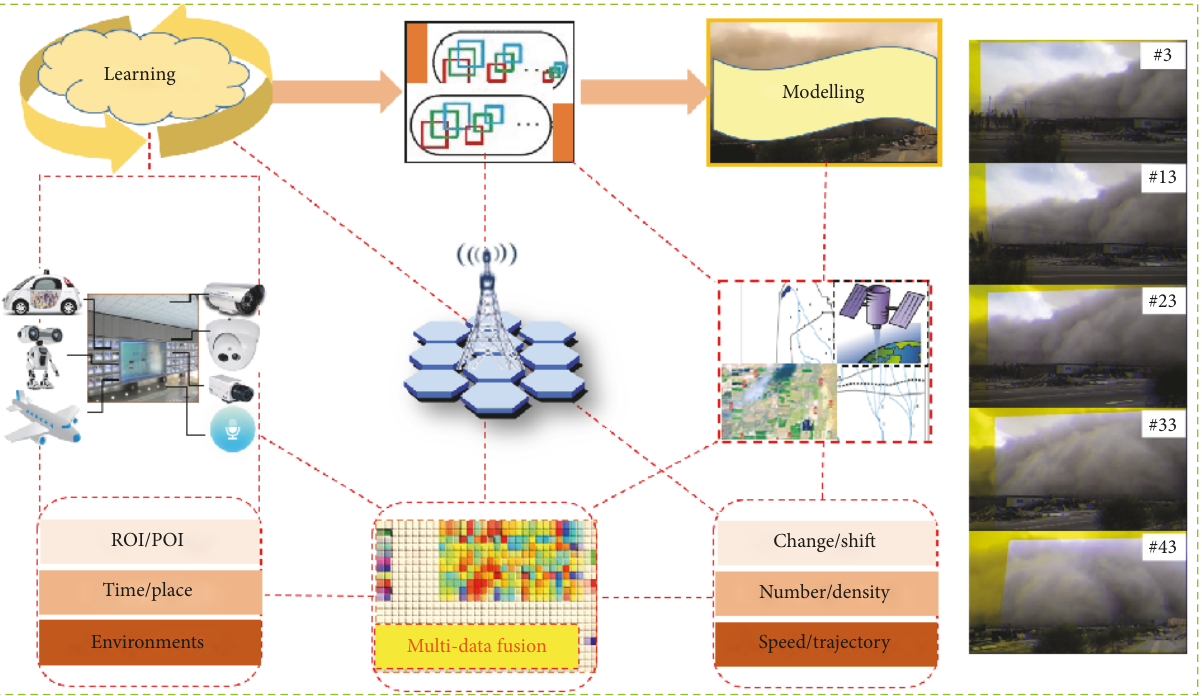
Figure 4: Implementation of the brain mechanisms of regulated attention and the corresponding determination of attention value and warning level, where a simple algorithm [28] is employed to generate a 3D stereo from a 2D video sequence and highlight evolution of environment changes.